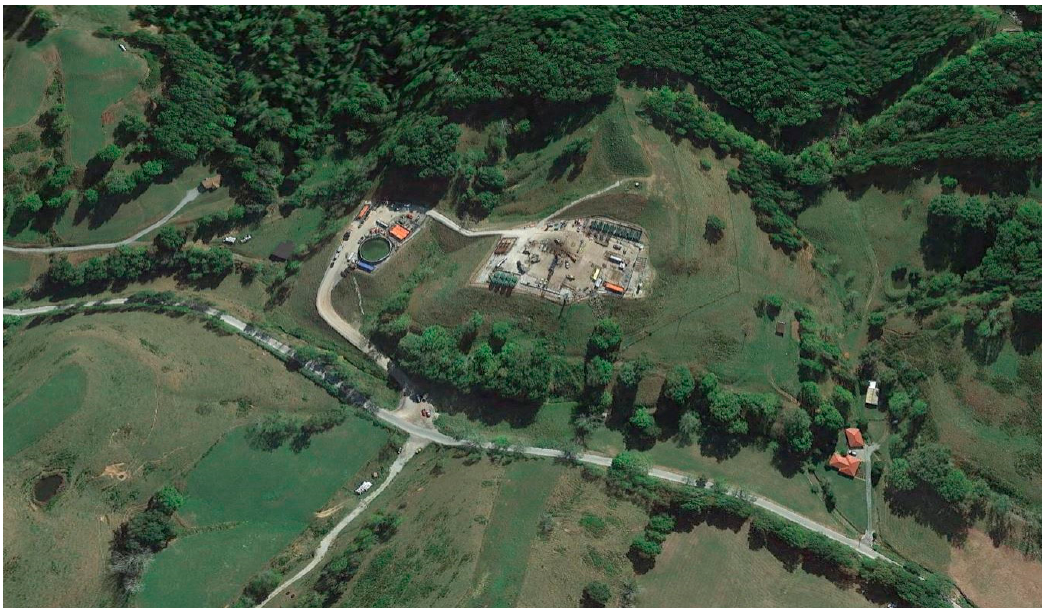
Figure 3. Well pad proximity to houses in northwestern West Virginia. In this photo, the well pad is approximately 650 feet from the house on the left, and 750 feet from the house on the right. Google Earth. 2 June 2019.